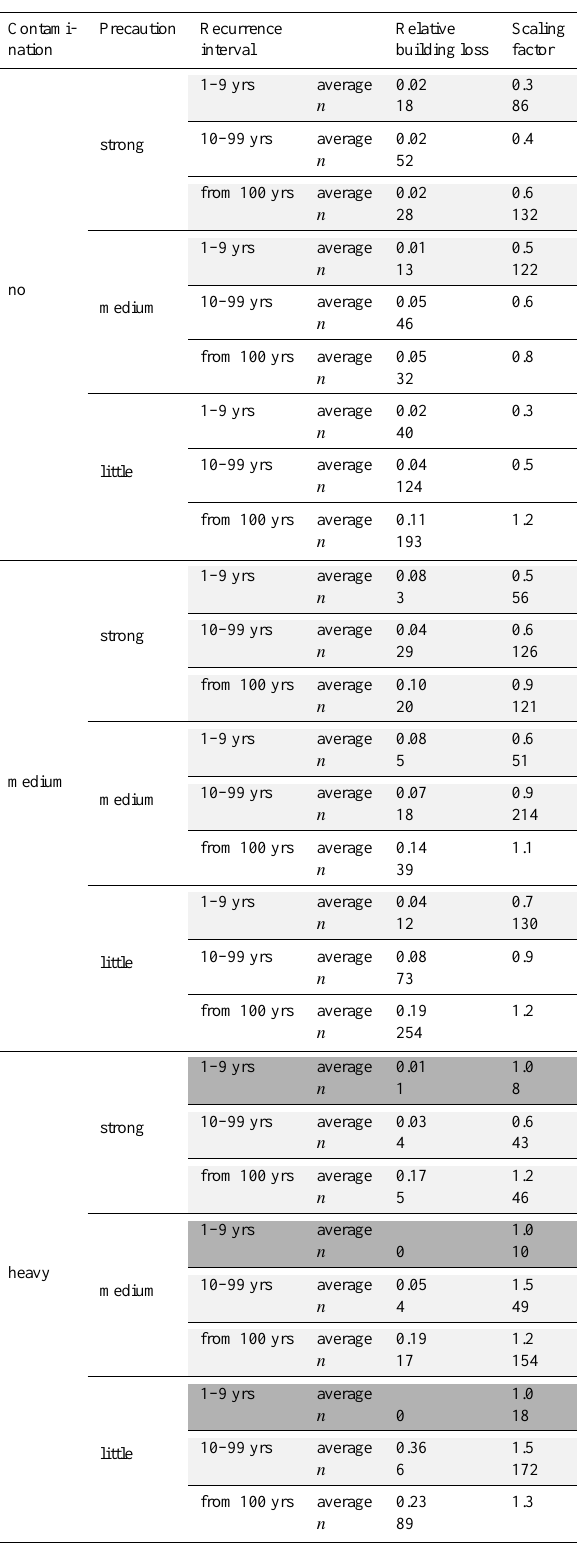
Table 5. Parameter combinations, class averages and scaling fac-